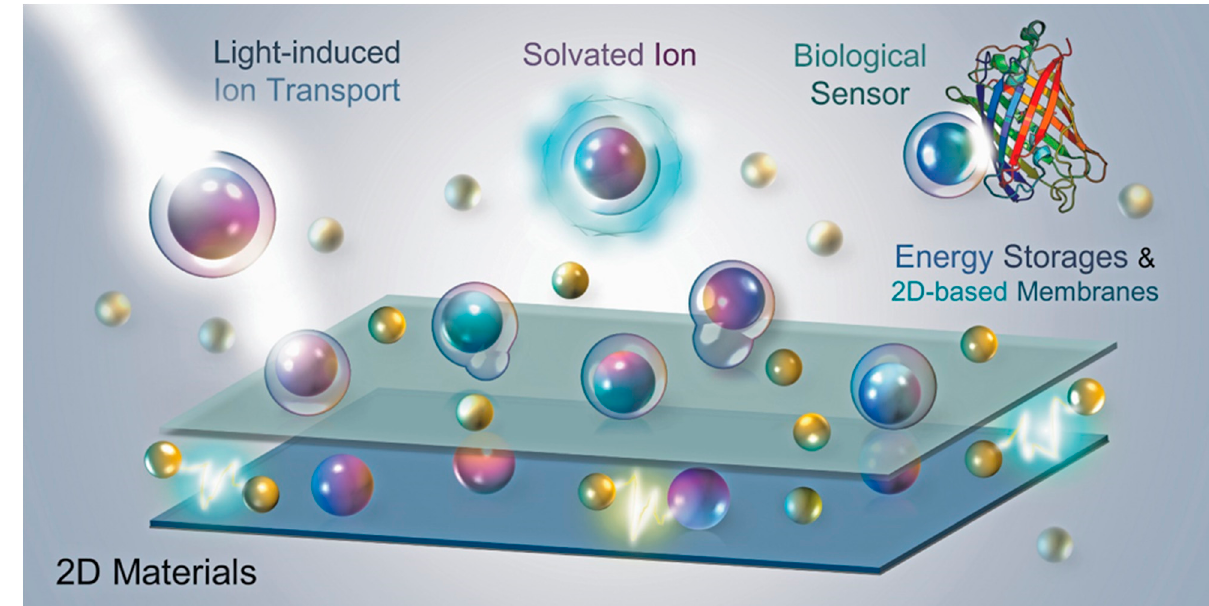
Figure 1. Diagram showing the potential applications of ion transport through two-dimensional (2D) materials, including the energy storages, 2D-based membranes for water purifications and energy harvesting (blue energy), light-induced ion transport, and biological sensors.